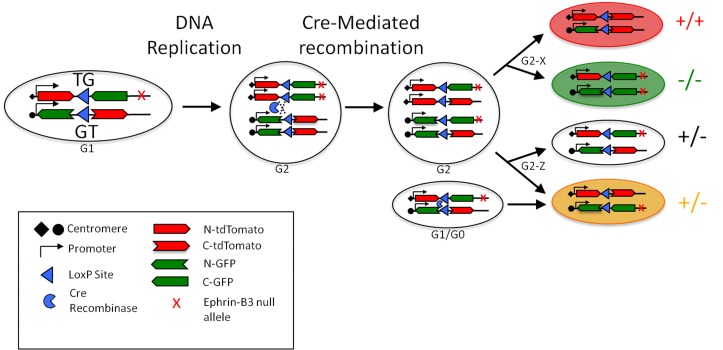
Schematic of recombination in eB3 MADM mice.(a) Interchromosomal recombination in eB3 MADM mice generates fluorescently labeled cells of known eB3 genotype. Cre-mediated recombination in G2 phase followed by segregation of chromatids into daughter cells generates a wild-type (tdTomato+) and an eB3 null (EGFP+) cell (G2-X segregation), or one unlabeled and one double-labeled cell with unaltered genotype (G2-Z segregation). Recombination in G1 or G0 phase results in a double-labeled cell with unaltered genotype. Adapted from Espinosa et al., 2009.